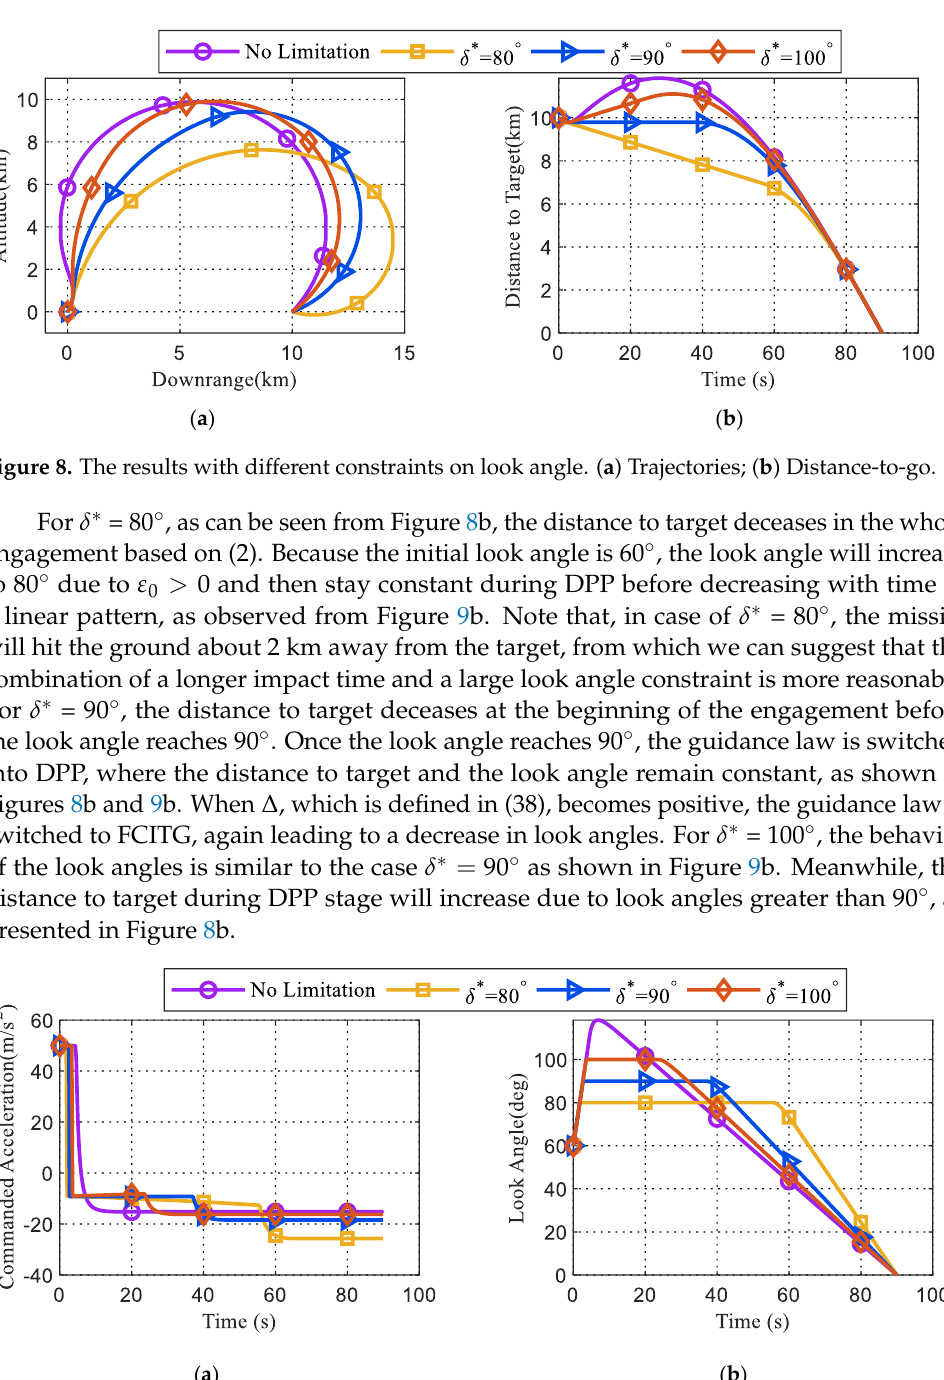
Figure 9. The results with different constraints on look angle. ( a ) Lateral accelerations; ( b ) Look angles.